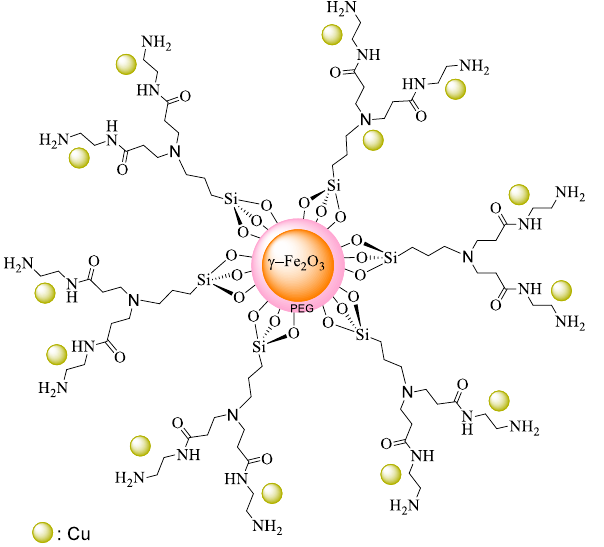
Figure 1. The proposed structure of γ-Fe 2 O 3 @PEG@PAMAM G 0